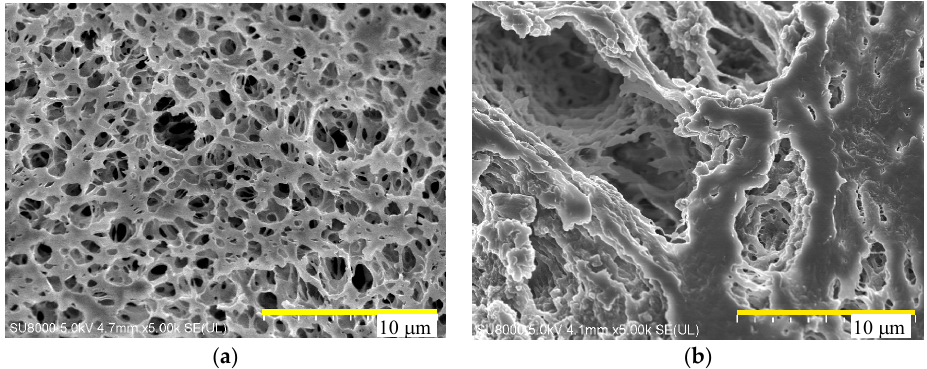
Figure 6. SEM images of the Accurel PP S6/2 membrane wall: ( a ) internal surface and ( b ) external surface.